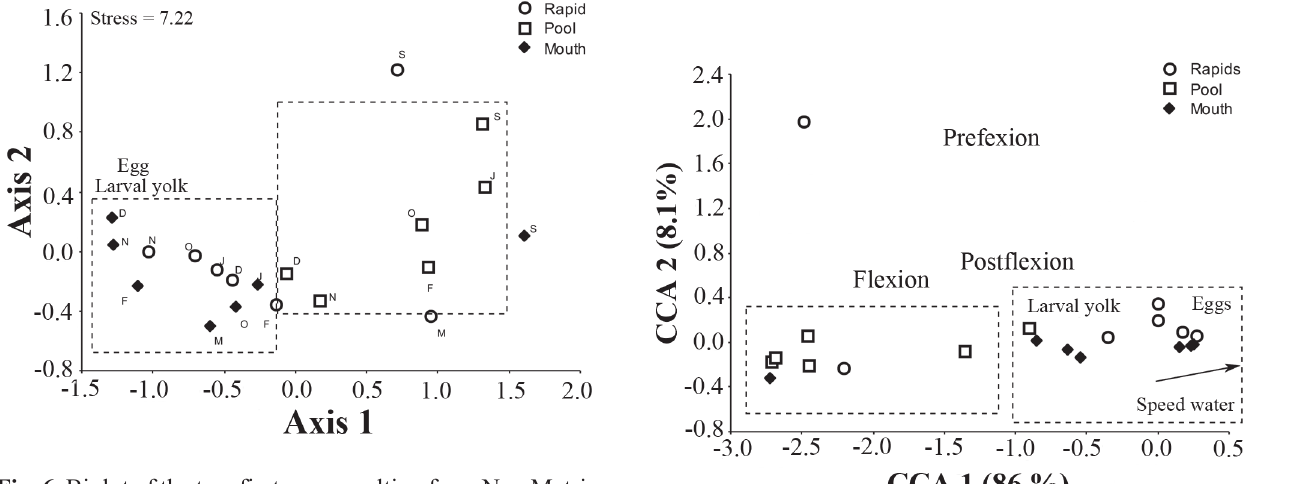
Fig. 6. Biplot of the two first axes resulting from Non Metric Multidimensional Scaling Analysis, showing spatial-temporal segregation of the sampled areas based on the abundance of the different stages of ichthyoplankton found in the Ligeiro River between September 2006 and 2007. S = September; O = October; N = November; D = December; J = January; F = February; M = March.